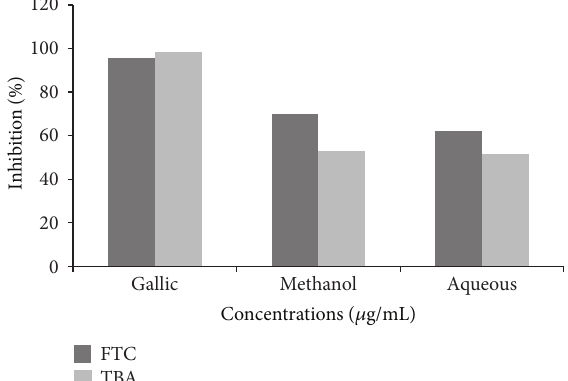
Figure 6: Antioxidant properties of leaves extracts of P. aculeate L. and gallic acid, determined by FTC and TBA methods. FTC: ferric thiocyanate; TBA: thiobarbituric acid.